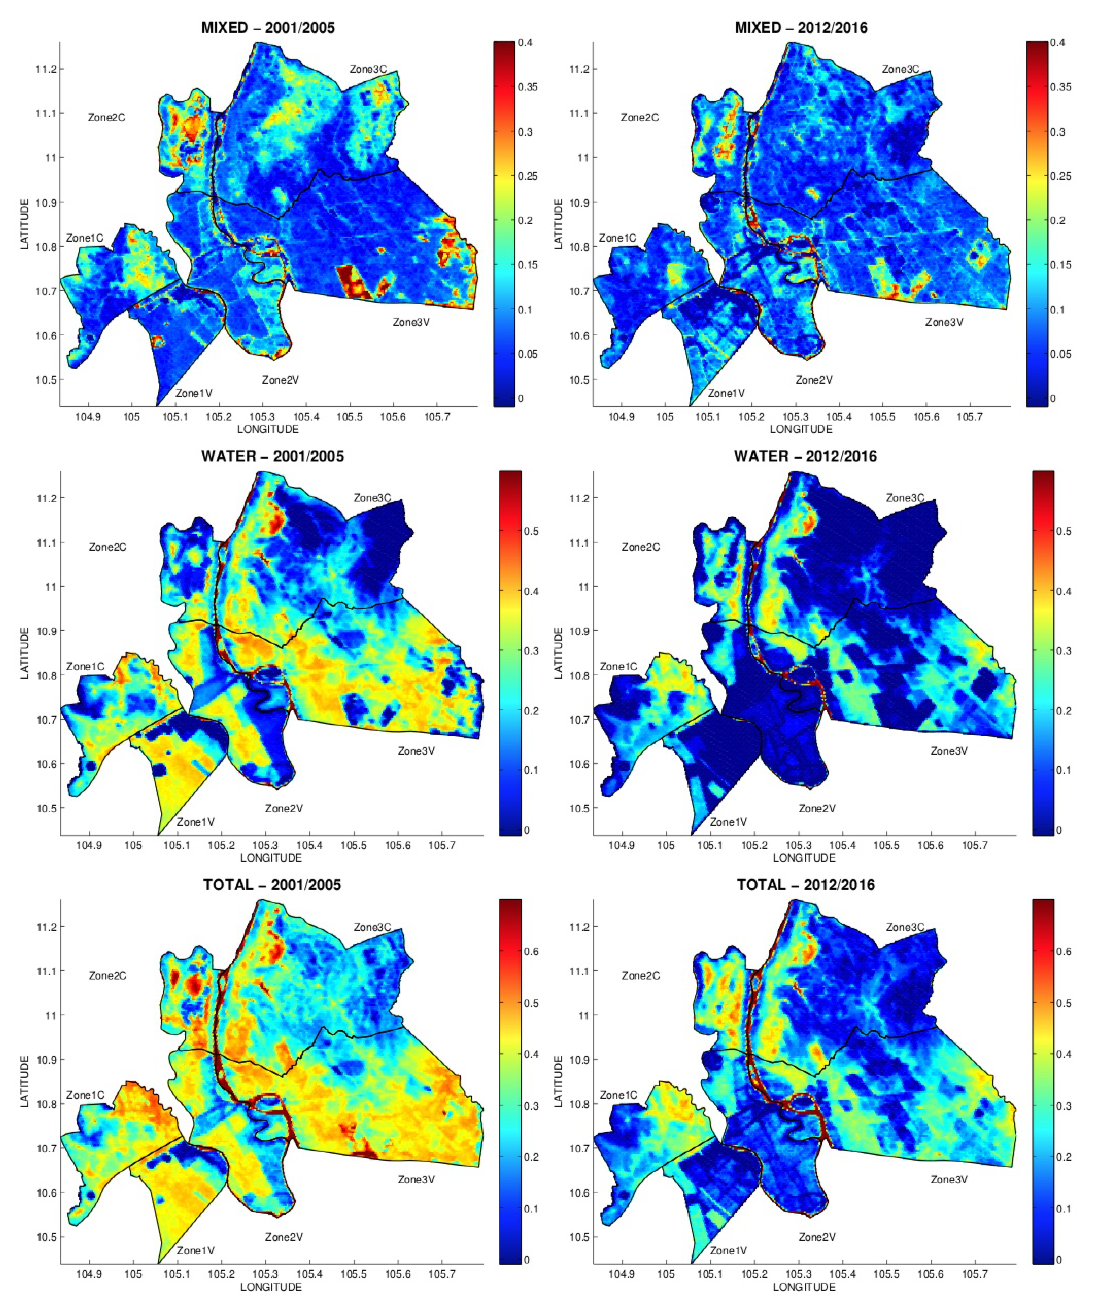
Figure 7. Frequency occurence (0–1) maps where 0 means never in a given state (mixed, water or total) and 1 means always in that given state, during the 2001–2005 ( left column ) and the 2012–2016 ( right column ) periods. From top to bottom, for mixed, water and total